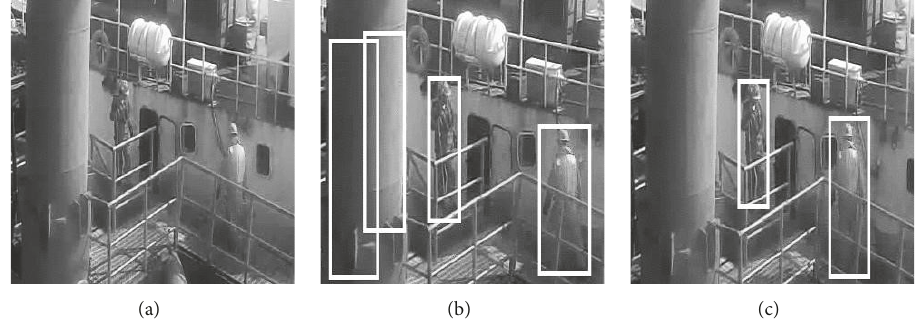
Figure 5: Target detection combined with classifiers in a marine platform scenario.